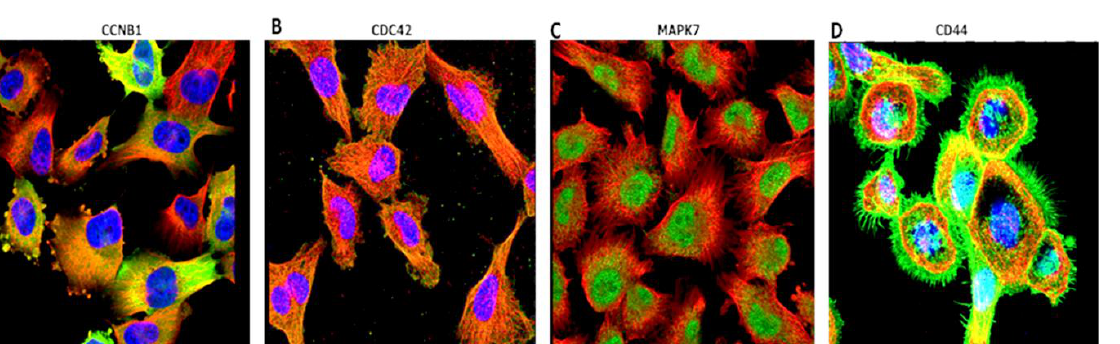
Figure 5. Increased expressions of CCNB1/CDC42/MAPK7/CD44 oncogenic signatures in glioblas-